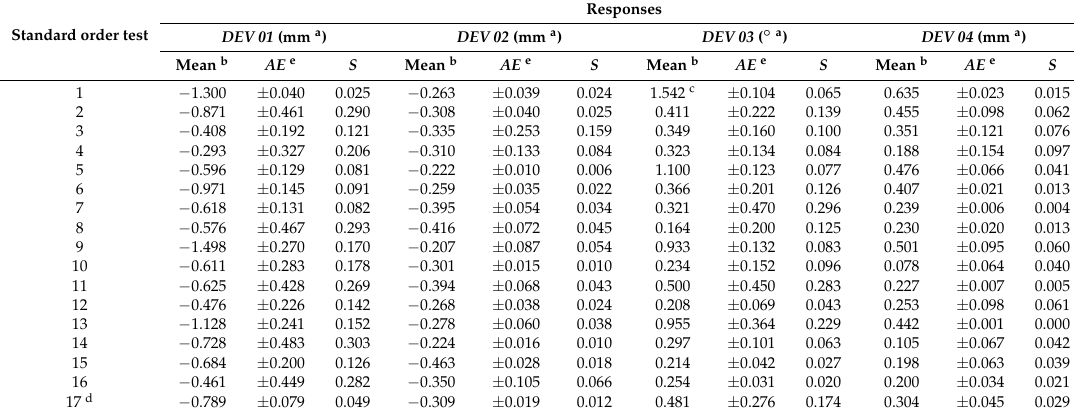
Table 2. Experimental main results.